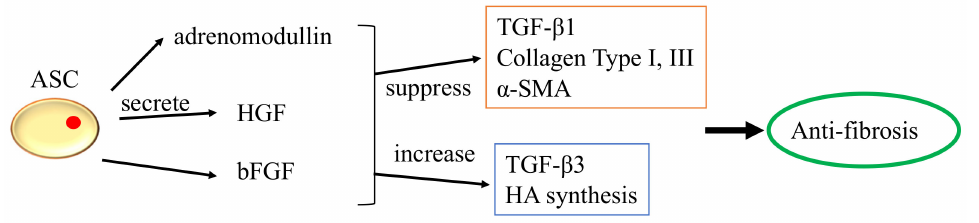
Figure 5. The anti-fibrosis function of